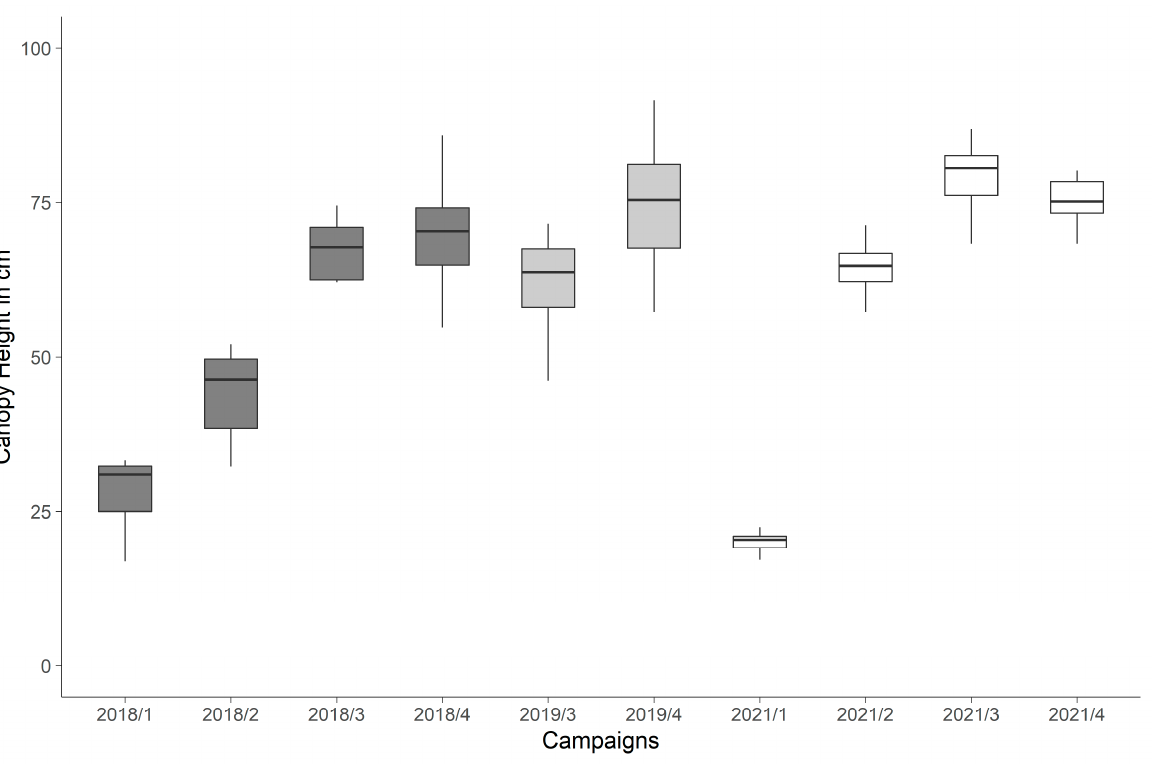
Figure 4. In-season and interannual comparison of measured canopy height exemplified by ESU 1 for winter wheat for the years 2018, 2019 and 2021. Dark greyish, light greyish and white boxplots display the campaigns in 2018, 2019 and 2021, respectively.